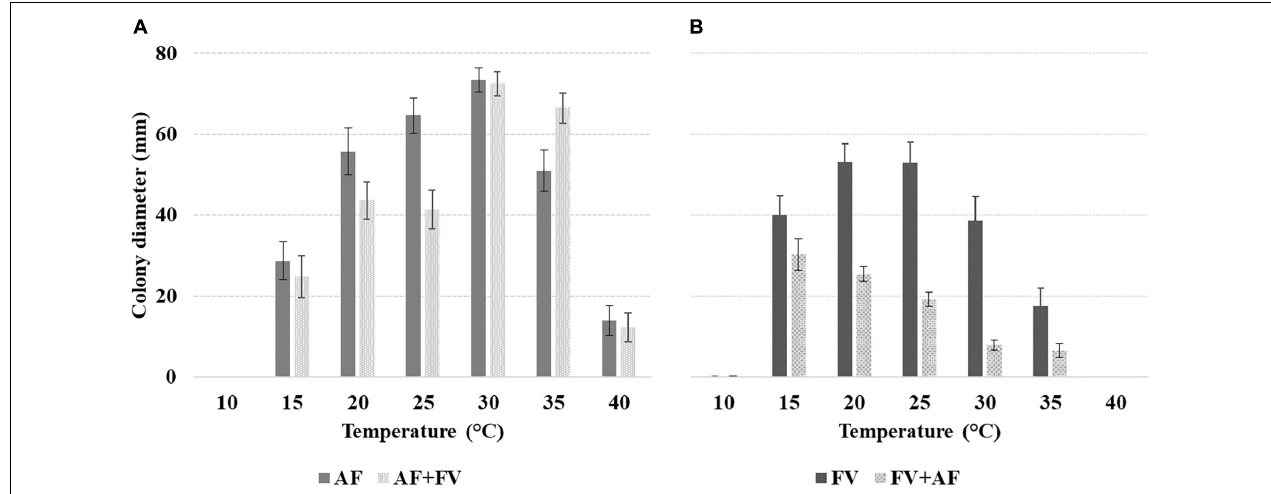
FIGURE 1 | Mean colony diameter (mm) of alone fungus inoculum of (A) Aspergillus flavus ( Af ) and together fungi inoculum of Af + Fv and (B) Fusarium verticillioides ( Fv ) and together fungi inoculum of Fv + Af , at different T of incubation (10–40 ◦ C, 5 ◦ C step) on both media considered (CMM and PDA). The bars indicate the mean standard error. All experiments were conducted using three replicates and were performed